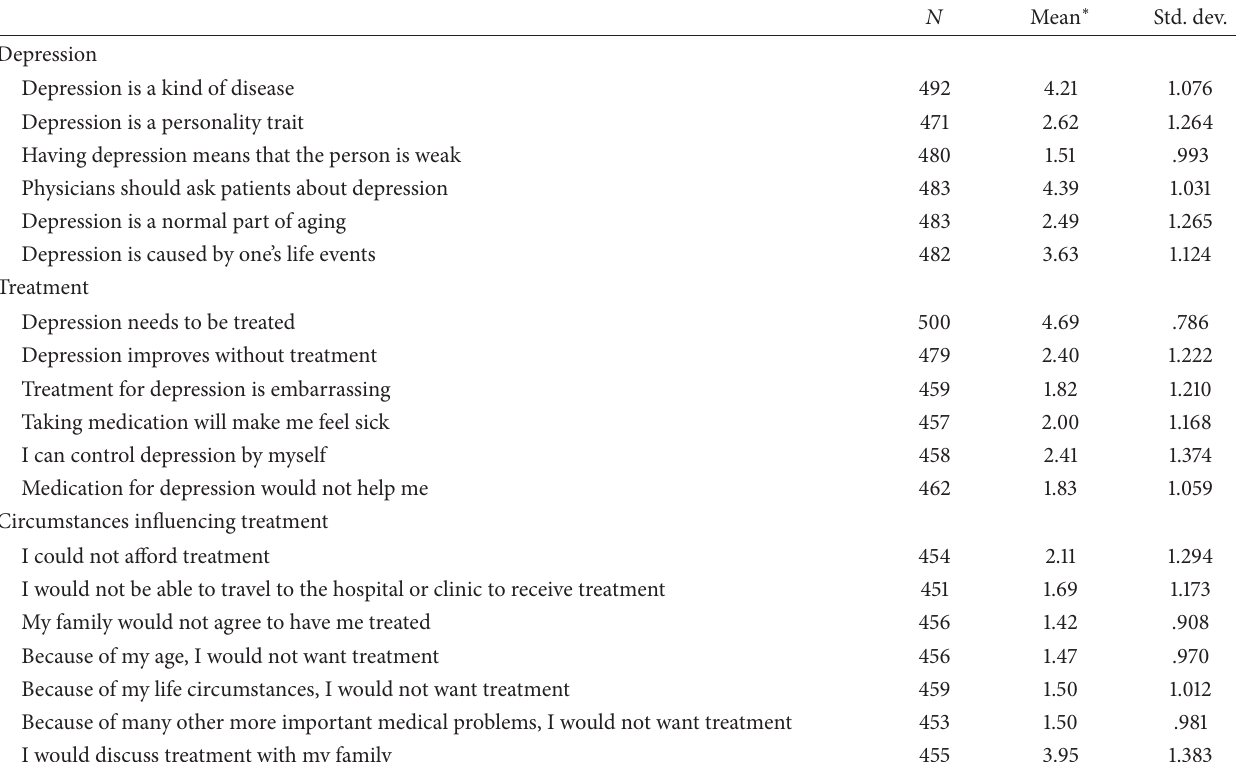
Table 2: Attitudes about depression and treatment.